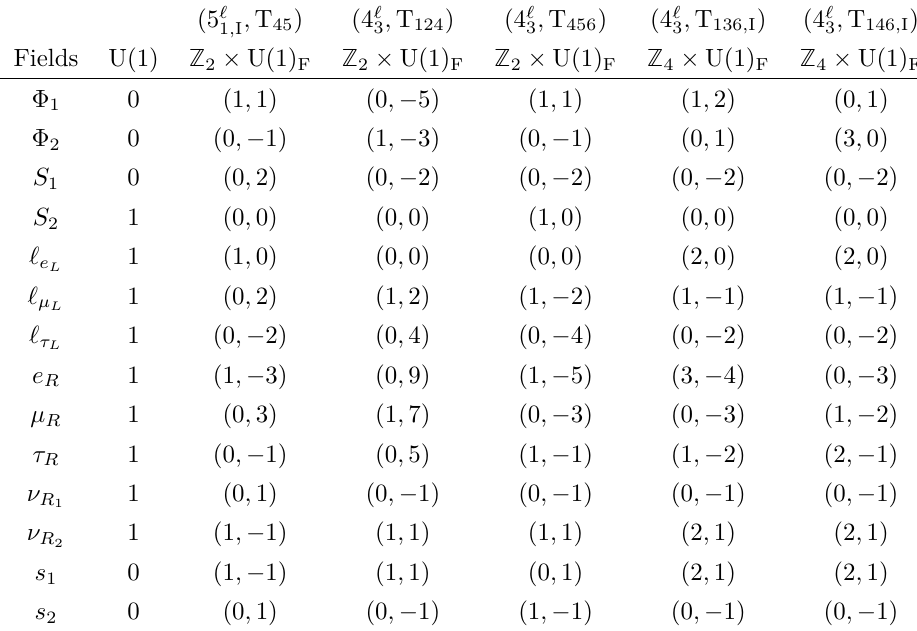
Table 6 . Maximally-restrictive texture sets realisable through an Abelian symmetry group. For each texture pair, we provide the Z The U(1) and U(1)